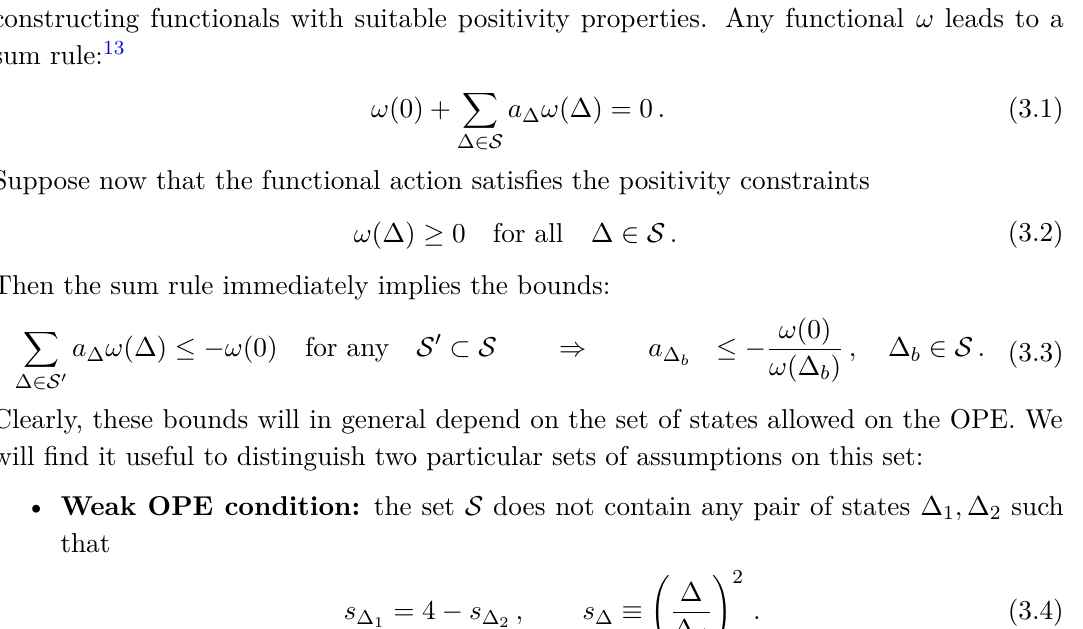
Figure 2 . In the flat space limit Polyakov blocks become piecewise functions defined in generically four distinct regions. The boundaries of these regions are set by the conditions arg [ G 0 ∪ arg [ G (1 − w | ∆ )] = 0 . We show these regions in the complex w plane for ∆ φ ∆ b √ ∆ = 2 (center) and ∆ = 1 . 1 b b